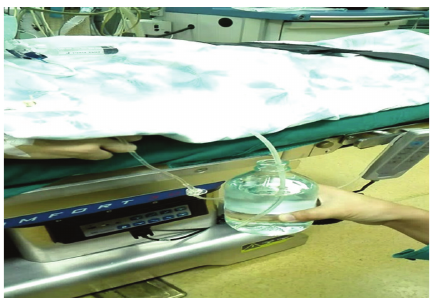
Figure 3: Patient lying on the operating table with his gastrostomy tube connected to an underwater seal bottle.